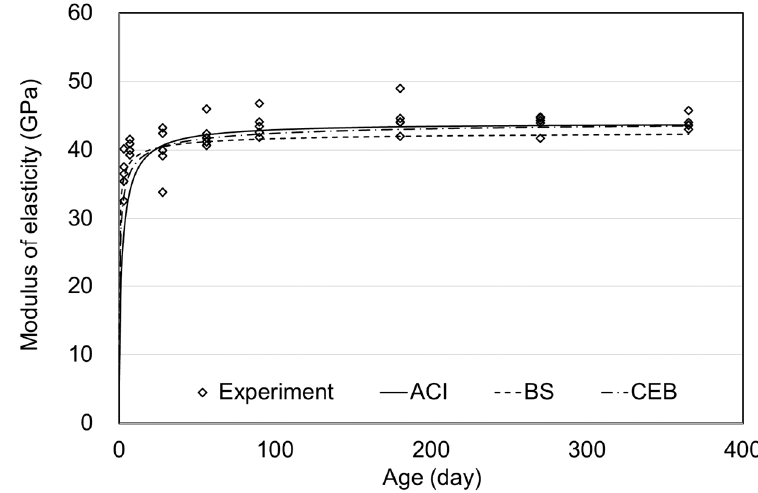
Figure 11. Elastic modulus of air curing.